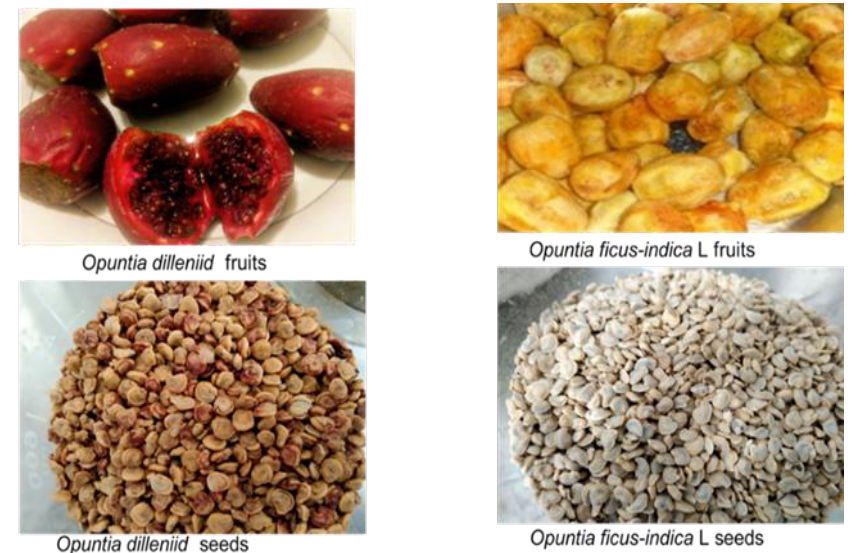
Figure 1. Appearance of Opuntia ficus-indica L. and Opuntia dillenii fruits and seeds. Due to the multiple health benefits of both OFI and OD seed oils, an efficient extraction process is of prime importance to preserve the quality of these oils. Different extraction processes have been applied for OFI and OD seeds, including maceration [10], cold press [14,17,18], ultrasound-assisted extraction [19], and Soxhlet [20,21].